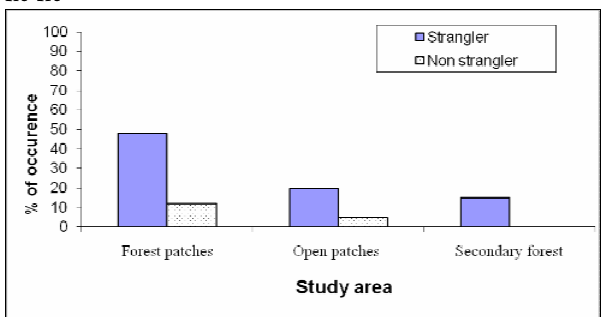
Fig. 3. Distribution of epiphytes into strangler and non- stranglers across the study sites